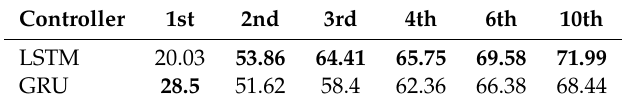
Table 3. A comparison of the model using two types of controller: LSTM and Gated Recurrent Unit